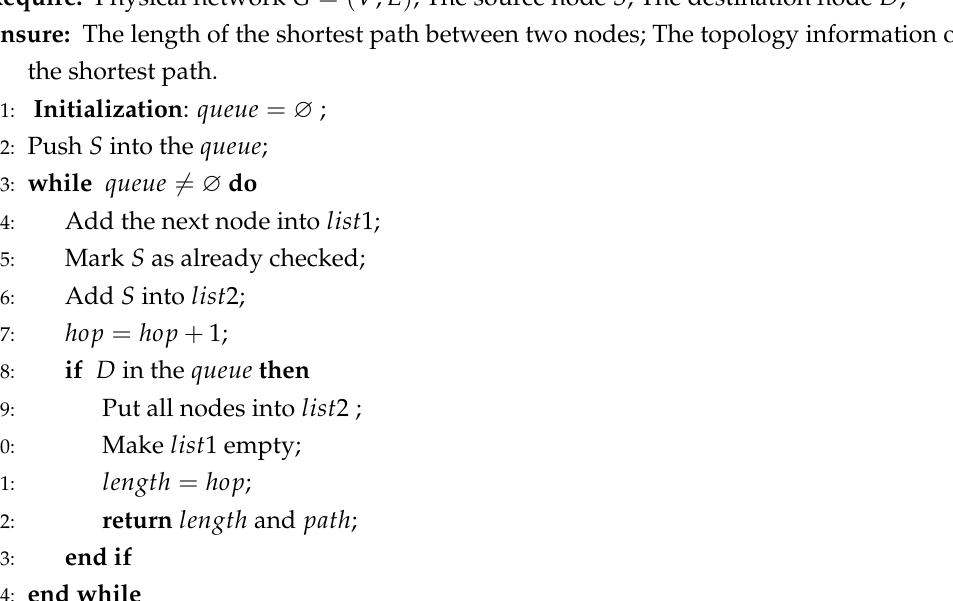
Algorithm 1 Breadth-First Search